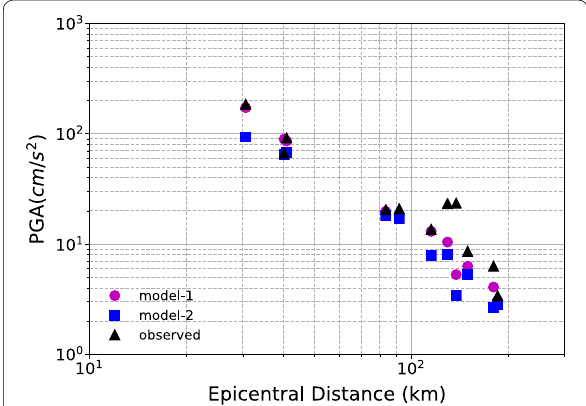
Fig. 8 Comparison of the synthesized with the recorded PGA for the two models at a selected station